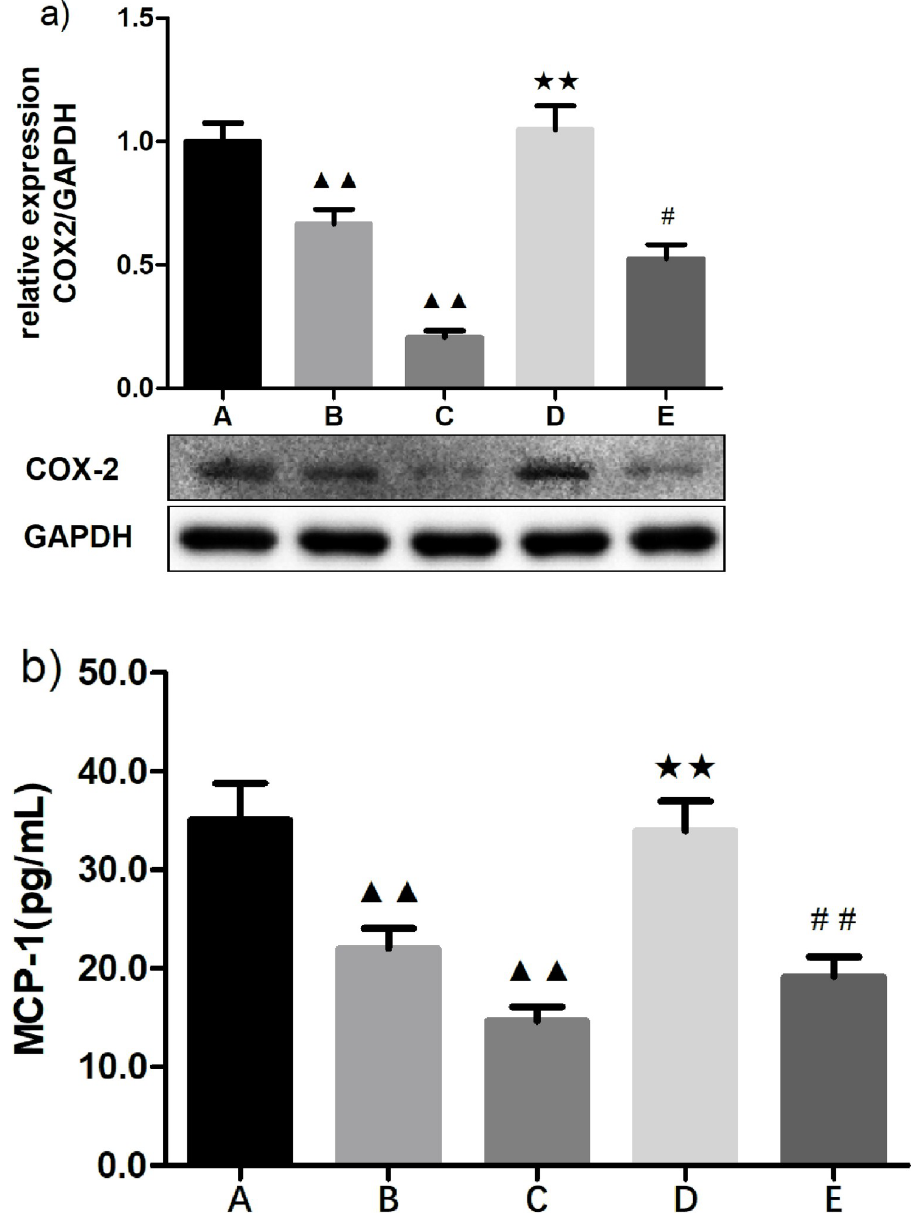
Fig 6. Effects of papain and miRNA-146a inhibitors on expression of COX-2 protein and MCP-1 in activated monocytes. ( � x ± s , n = 3 for COX-2 and n = 6 for MCP-1). a) Expression of COX-2 protein detected by western blot and b) MCP-1 expression was analyzed by ELISA in a co-culture system of THP-1 cells and activated platelets treated with 100 or 200 U/L of papain and miRNA-146a inhibitors, respectively. A: negative control; B: 100 U/L papain; C: 200 U/L papain; D: 100 U/L papain with miRNA-146a inhibitors; E: 200 U/L papain with miRNA-146a inhibitors. # P < 0.05 compared with 200 U/L papain group; ▲▲ , ✭✭ , ## P < 0.01 compared with negative control, 100 U/L papain, and 200 U/L papain, respectively, as analyzed by LSD- t